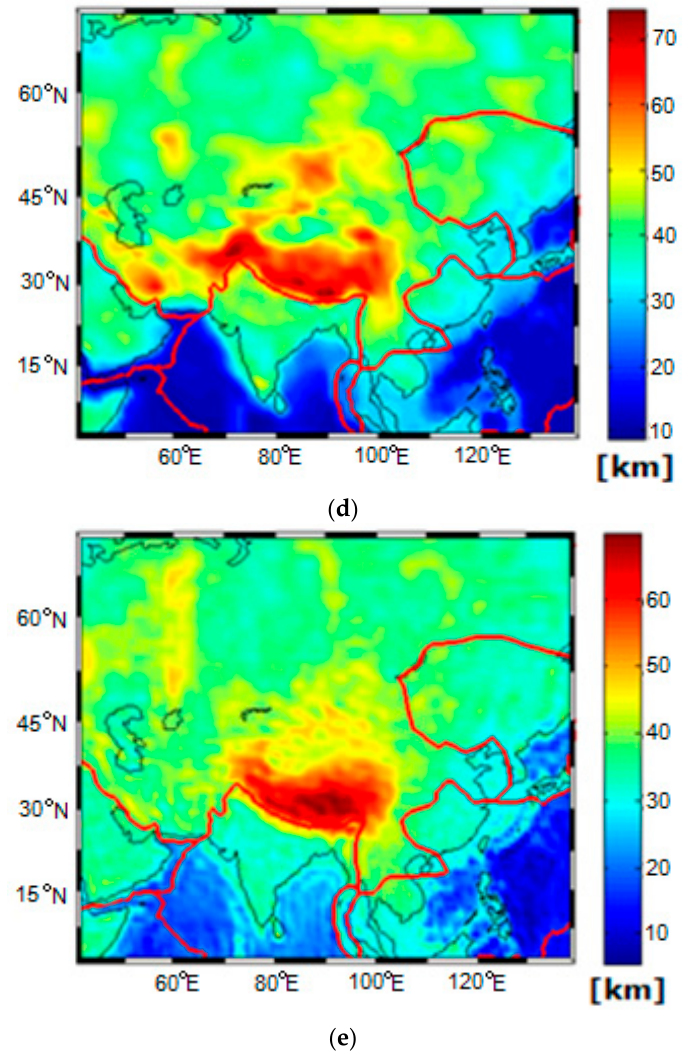
Figure 8. Moho depth from: ( a ) CRUST1.0; ( b ) KTH1.0; ( c ) GSMM; ( d ) M13 and ( e ) GEMMA models.